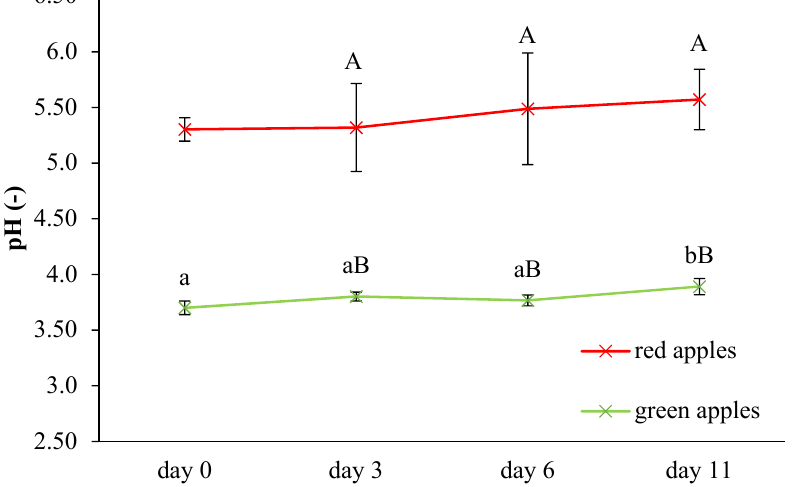
Figure 1. Determination of red and green apples’ pH during storage (uppercase letters indicate statistically significant differences ( p < 0.05) between red and green apples; lowercase letters indicate significant differences ( p < 0.05) between days of storage).